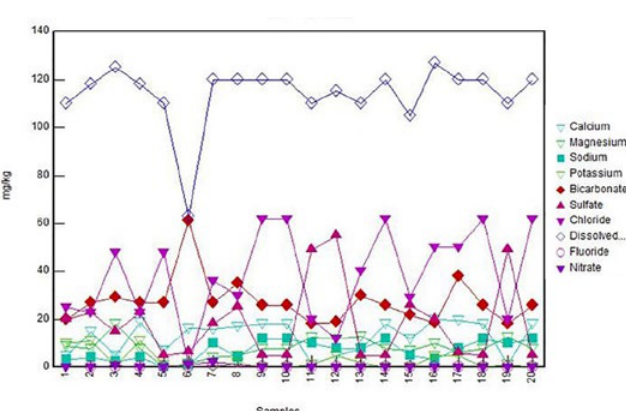
Fig. 2: Series plot for UAE brands